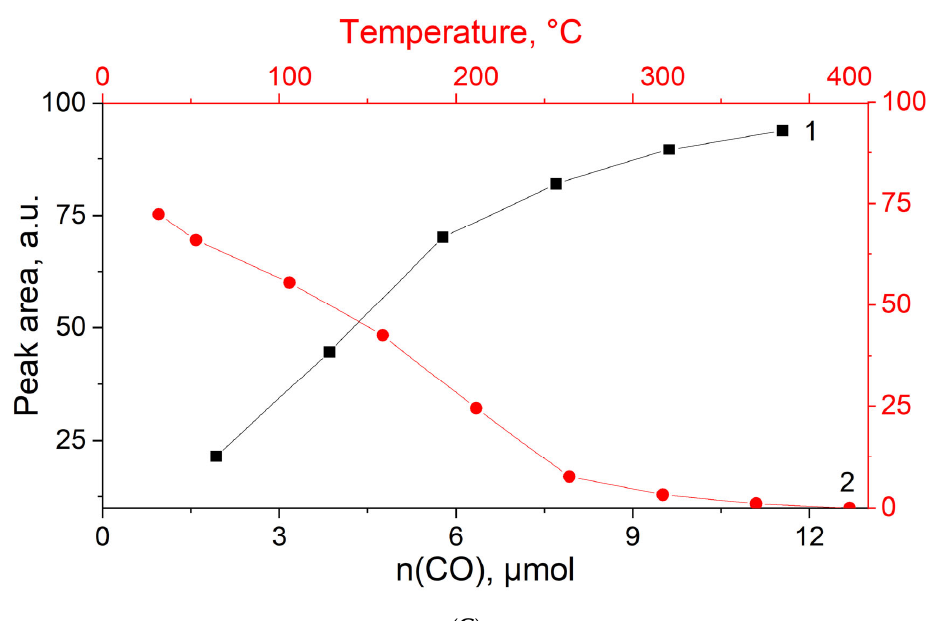
Figure 5. ( A ) Difference FTIR spectra of CO adsorbed on MOR ‐ Cu(NO 3 ) 2 . CO titration experiment with increments of ~2 µ mol of CO. ( B ) Stepwise desorption at different temperatures; difference FTIR spectra of CO adsorbed on Cu(NO 3 ) 2 ‐ impregnated MOR. ( C ) Evolution of the IR peak area following CO adsorption on MOR ‐ Cu(NO 3 ) 2 (1), and evolution of IR peak area during stepwise de ‐ sorption at different temperatures of CO on MOR ‐ Cu(NO 3 ) 2 (2).